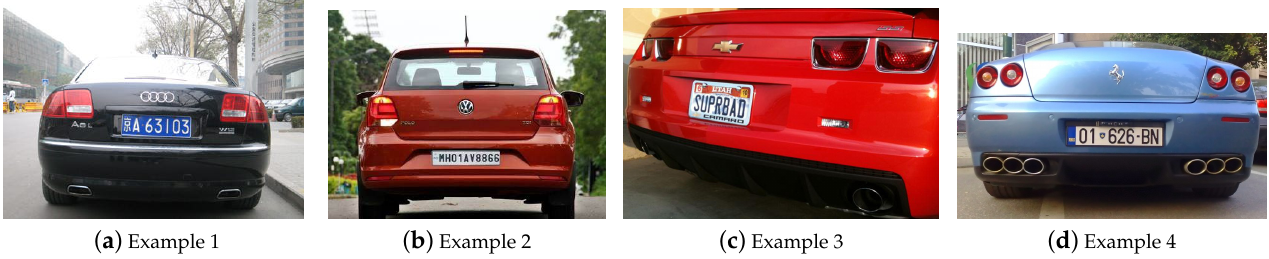
Figure 1. Sample Examples from our Dataset Showing Different Types of Plates with Different Orientations and Shapes Across Various Regions